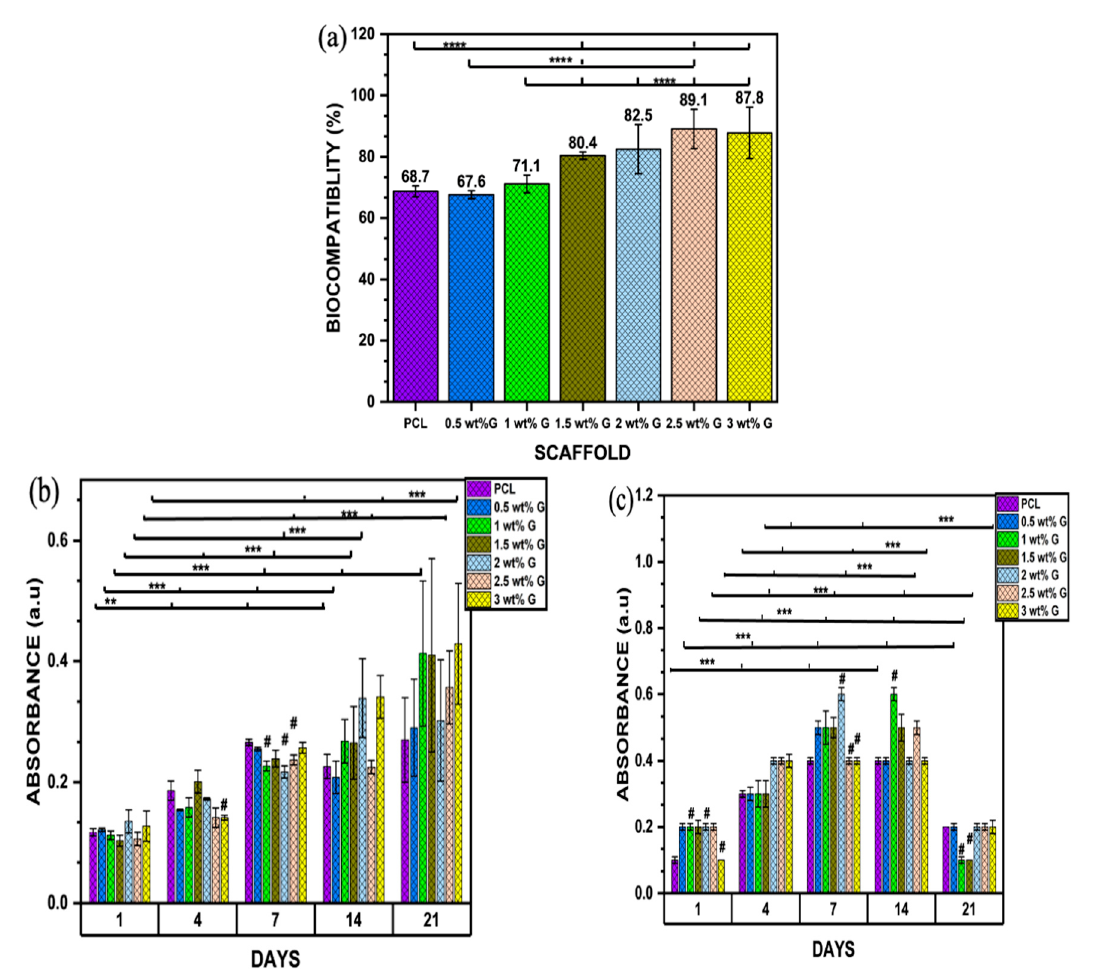
increased, while that of the ALP declined [60,61]. wt% G were appropriate for the growth of cells [59].